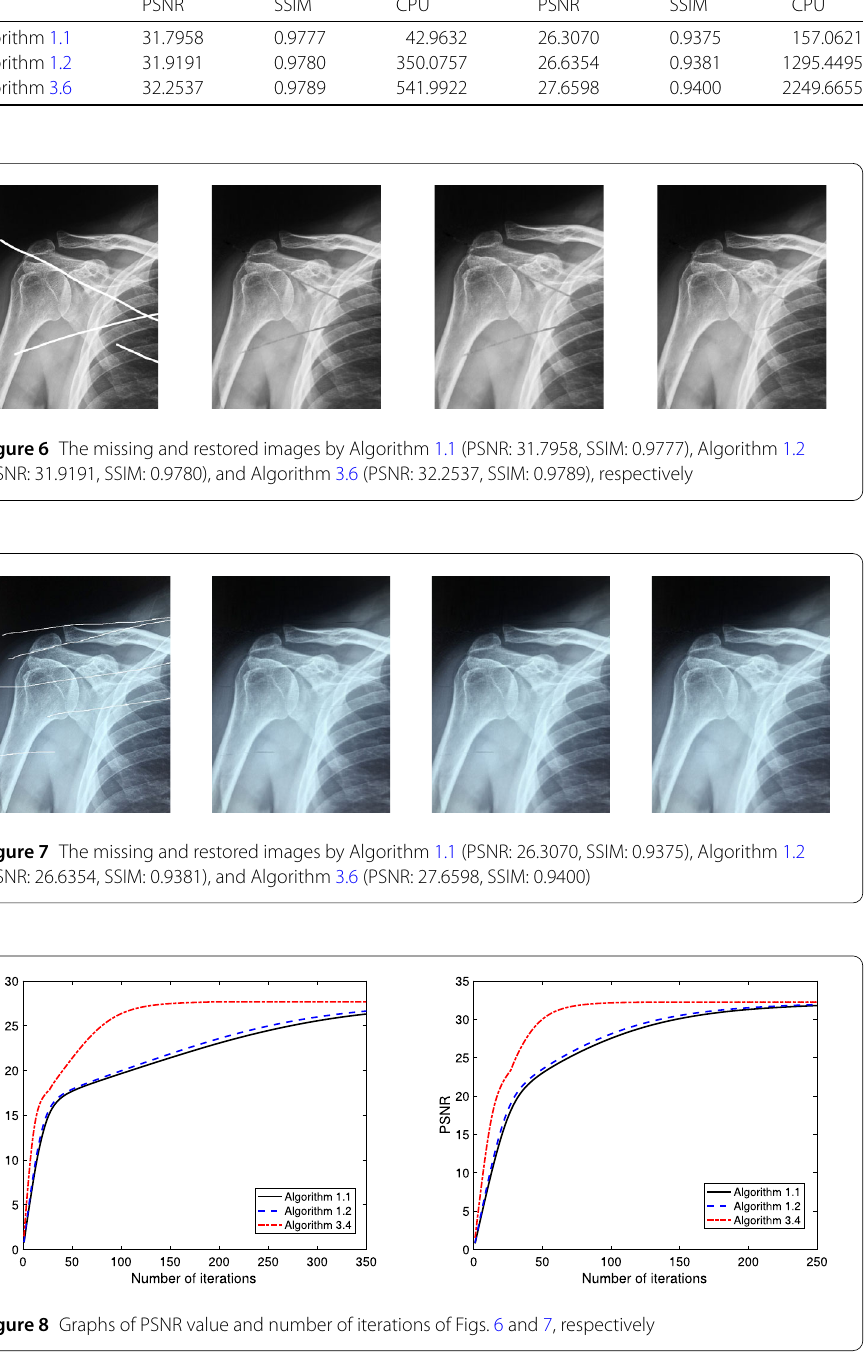
Table 6 Computational results for solving (4.3) Methods Algorithm 1.1